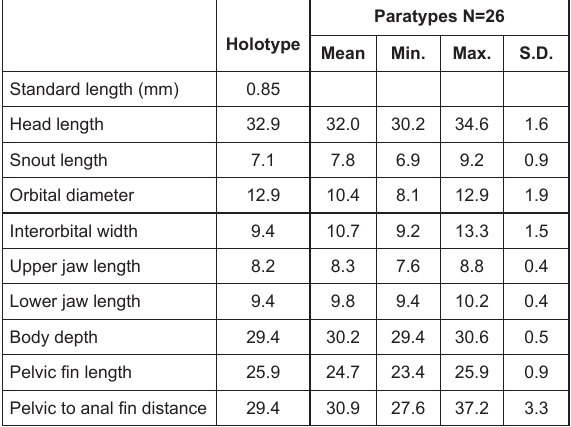
Table 1. Proportional measurements of Badis singenensis sp. nov. in percentage of standard length except standard length.